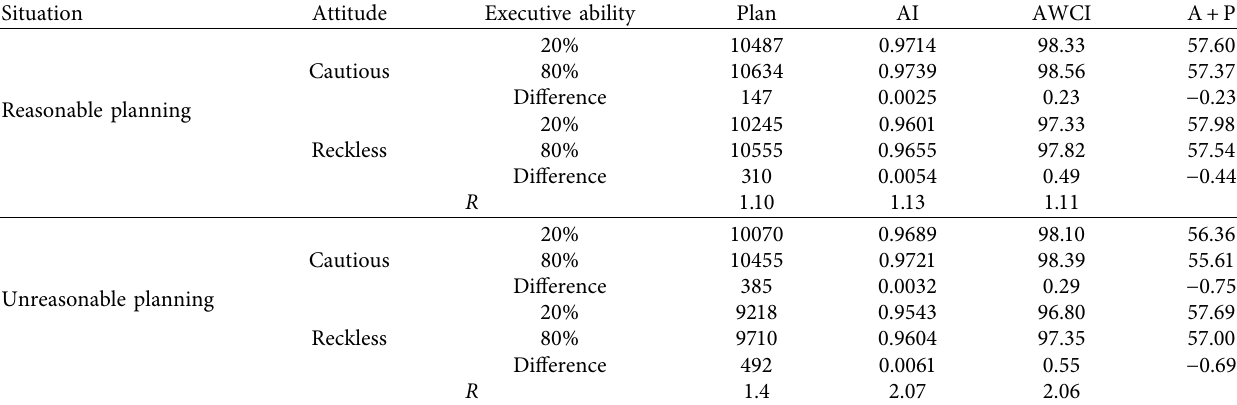
Table 6: Comparison of utility when enhancing executive ability of planning under different risk preferences.